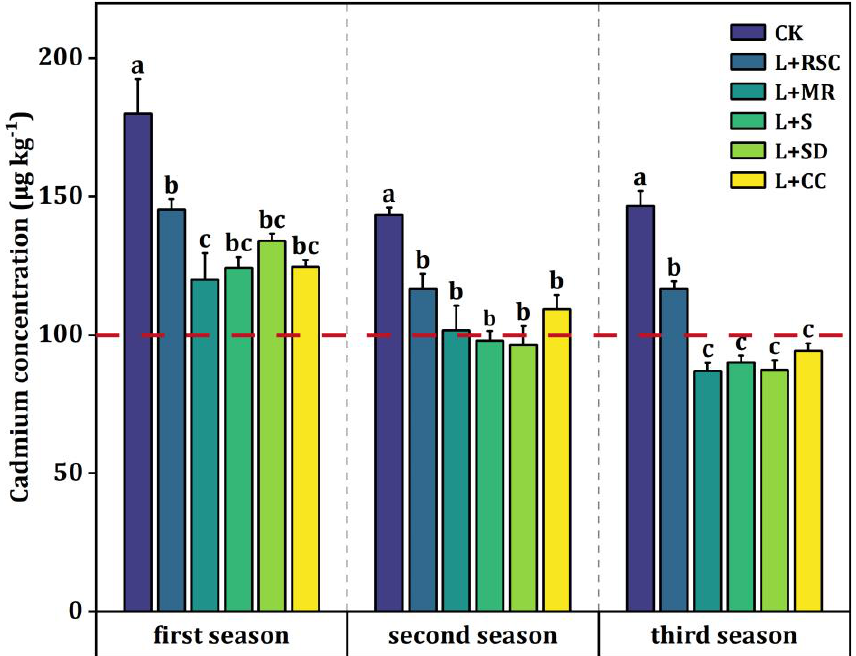
Figure 5. Effect of LOM on Cadmium concentration in edible parts of A. selengensis over three seasons. All values are means of three replicates with error bars indicating the standard error. Different lowercase letters show significant variability among treatments ( p < 0.05). The red dashed line indicates the standard limit of 0.1 mg kg −1 according to the Chinese Quality Standard for Food Safety-Limits of Contaminants in Food.